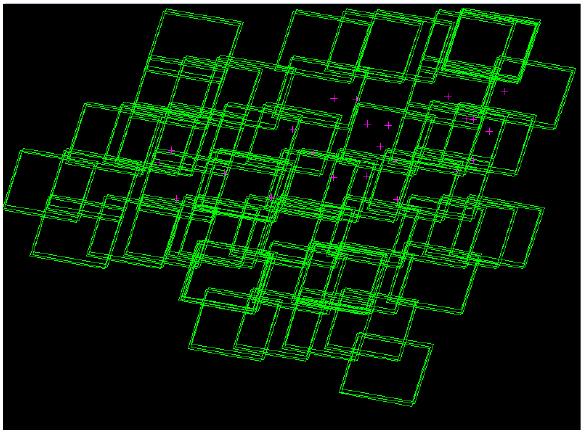
Figure 3. Distribution of checkpoints on reference triangulation model (pink cross is checkpoint )